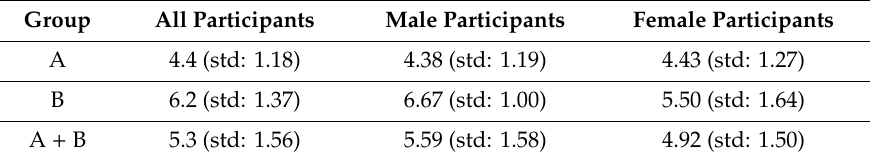
Table 2. Number of personas constructed per participant group (task) and